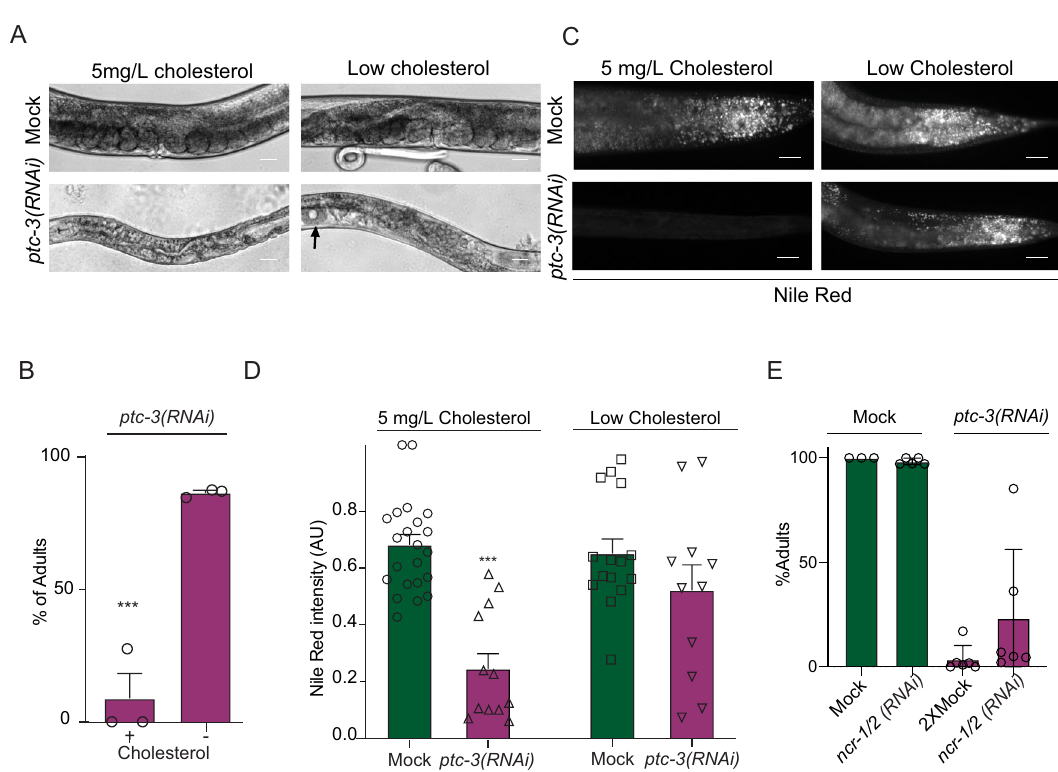
Fig. 3 Low dietary cholesterol rescues ptc-3(RNAi) induced phenotypes. Worms were fed from L1 larva under standard cholesterol conditions (5 mg/l) or low cholesterol conditions (no added cholesterol) for 3 days. A Representative light microscopy images of mock- or ptc-3(RNAi) -treated worms on low cholesterol plates Scale bars 20 µ m. B Quanti fi cation of number of ptc-3(RNAi) -treated worms that reached adulthood in the absence of cholesterol in the growth medium. Mean and SEM error bars, unpaired one-tailed T test *** p = 0.000565 n = 83 (mock) and 93 ( ptc-3(RNAi )) animals from four independent experiments. C Nile Red staining of lipid droplets in C. elegans adult mock- and ptc-3(RNAi) -treated after L2 stage on normal or low cholesterol conditions. In low cholesterol conditions, lipid droplet levels are restored in ptc-3(RNAi) animals. Scale bars 20 µ m. D Quanti fi cation of Nile Red staining of data shown in ( C ) Mean and SEM error bars. *** p = 0.000003 n = 22 (mock) n = 12 ( ptc-3(RNAi )) n = 15 (low cholesterol mock) and 11 (low cholesterol ptc-3(RNAi )) animals. One-way ANOVA including data on Fig. 1C. The normal cholesterol data are the same as depicted in Fig. 1E. E Quanti fi cation of number of ptc-3(RNAi) -treated worms that reached adulthood in combination with ncr-1/2(RNAi) . Mean and SEM error bars, n = 121 (Mock), 493 ( ncr-1/2 (RNAi )), 408 (2X Mock), and 295 ( ncr-1/2(RNAi ); ptc-3(RNAi )) animals from three independent experiments. Statistical source data are available as source